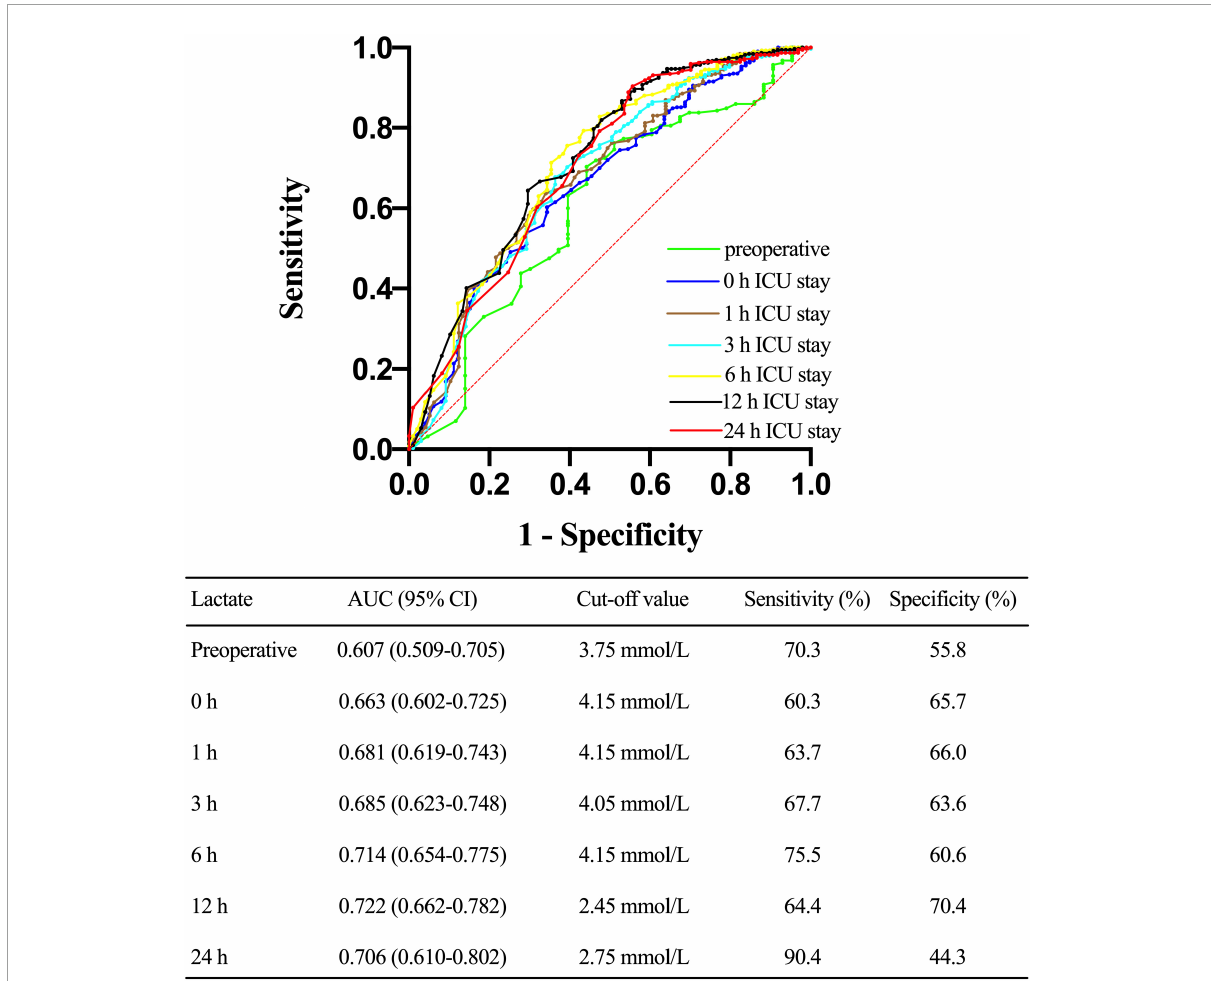
FIGURE6 Receiver operating characteristic (ROC) curve comparing the ability of preoperative, 0, 1, 3, 6, 12, and 24 h lactate levels after ICU admission in predicting the requirement for continuous renal replacement therapy (CRRT) after acute type A aortic dissection (ATAAD) surgery. AUC, area under the curve; CI, confidence